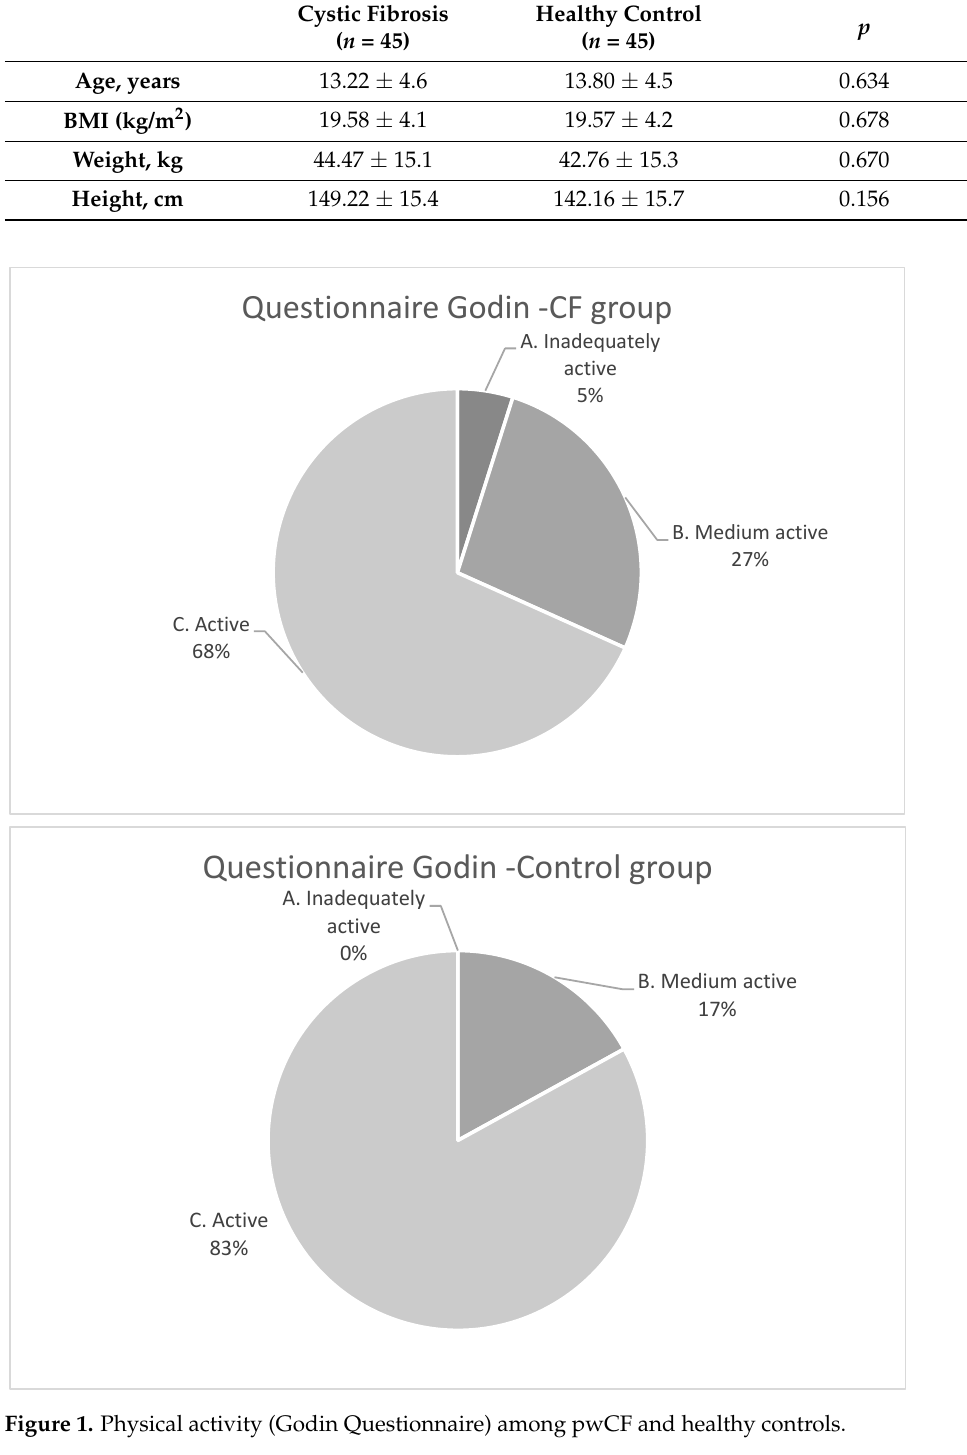
Figure 2. Healthy and patient participants’ quality of life (DISABKIDS questionnaire) and physical activity (Godin Q). PwCF were more independent compared to their healthy peers; while they presented a more affected QoL in total and experienced more physical restriction due to the disease, they also experienced a negative impact on their emotional health and social exclusion (stigma, feeling left out) ( p < 0.05, Figure 2). Moreover, a positive correlation between physical activity level and emotional health was observed (r 2 : 0.414, p < 0.05, Figure 3). Moreover, patients with more significant phys- ical activity levels showed a better overall QoL (r 2 : 0.372, p < 0.05, Figure 4).